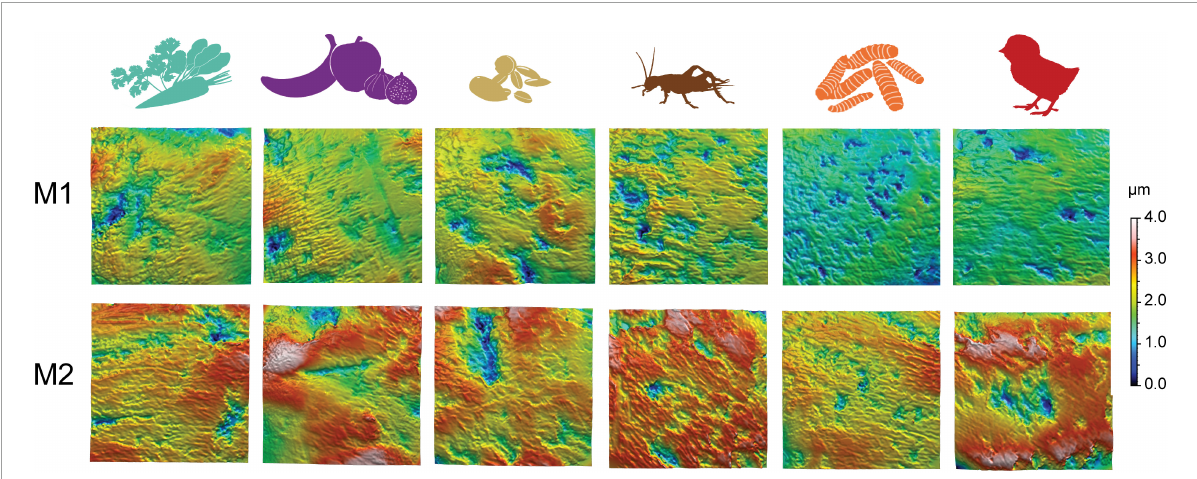
FIGURE2 Exemplary 3D photosimulations of representative enamel surface scans for each diet group (from left to right: vegetable mix, fruit mix, seed mix, crickets, BSFL, black soldier fly larvae, and daychicks). Scans of the first (M1) and second upper molars (M2) belong to the same individual and are displayed on the same scale. Each surface scan is 60 × 60 µ m.